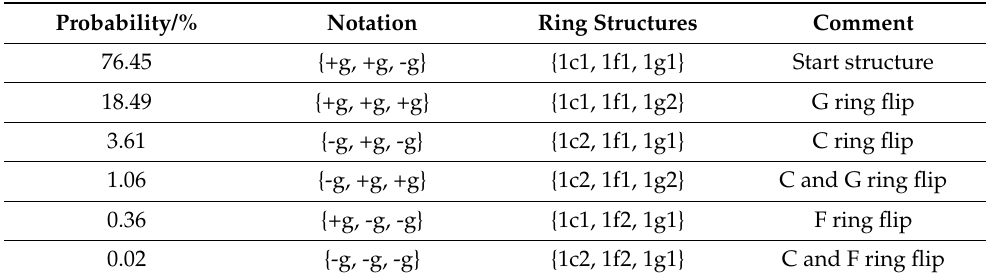
Table 3. Probabilities for ring conformers of the C, F and G ring and combinations of the conformers. The notation +gauche/ − gauche notation is given for the torsion angle combination {C7-C17-C18-N17,